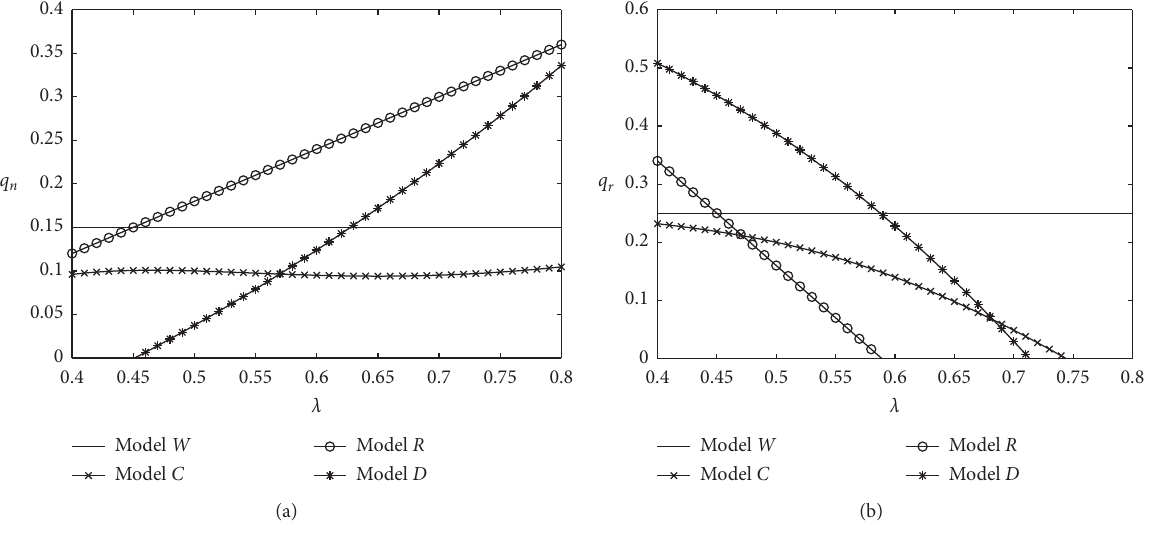
Figure 4: The impact of λ on